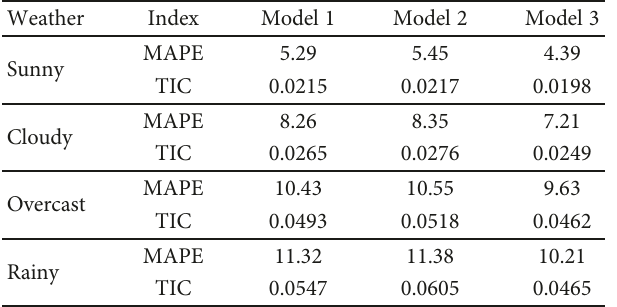
Table 6: Statistics of forecasting errors for combination models.